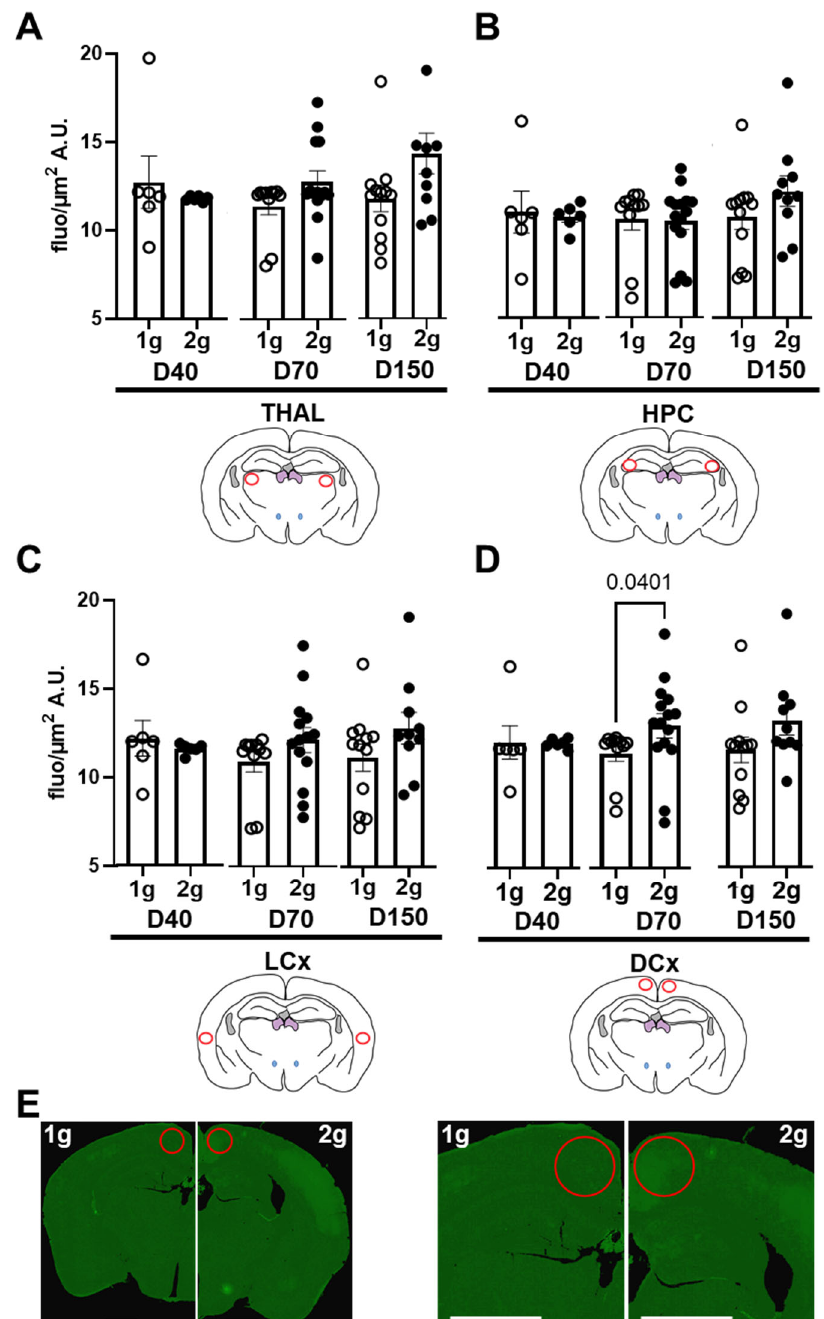
Figure 3. Effects of centrifugation on extravasation of fluorescent dextrans in brain. Measures were performed on Nanozoomer images from ( A ) thalamus (THAL), ( B ) hippocampus (HPC), ( C ) dorsal (DCx) and ( D ) lateral (LCx) cortices. Fluorescence levels were used as an index of extravasation. They were expressed as grey level (arbitrary unit, A.U.) per surface ( μ m 2 ) of the D40 (n = 11), D70 (n = 25) and D150 (n = 22), measured in both normogravity (1 g, circle) and hypergravity (2 g, point) conditions. Red circles on schema of the brain slices represented the ROI used for the analyses, and the p values < 0.05 are indicated. ( E ) Typical images obtained with Nanozoomer of brain slice from D70 ‐ injected mice exposed to normogravity (1 g, left) and hypergravity (2 g, right). The right panel is a magnification of the left one. Red circles indicate the ROI used for fluorescence measurements. Scale bar represents 1